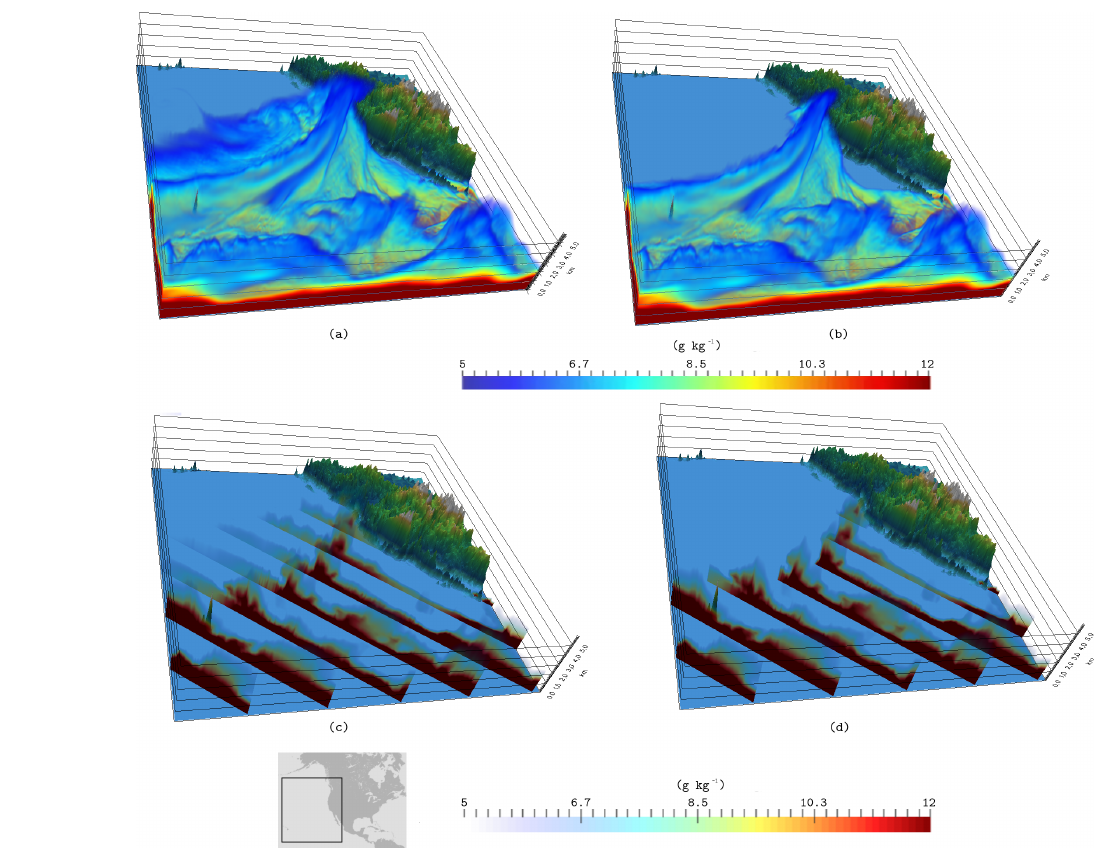
Figure 5. (a) Total water vapor mixing ratio in grams per kilogram at 3 December 2007 12:00UTC for the Pacific domain. (b) Tracers water vapor mixing ratio in grams per kilogram at the same time and domain. (c) Vertical cross sections of (a) . (d) Vertical cross sections of (b)